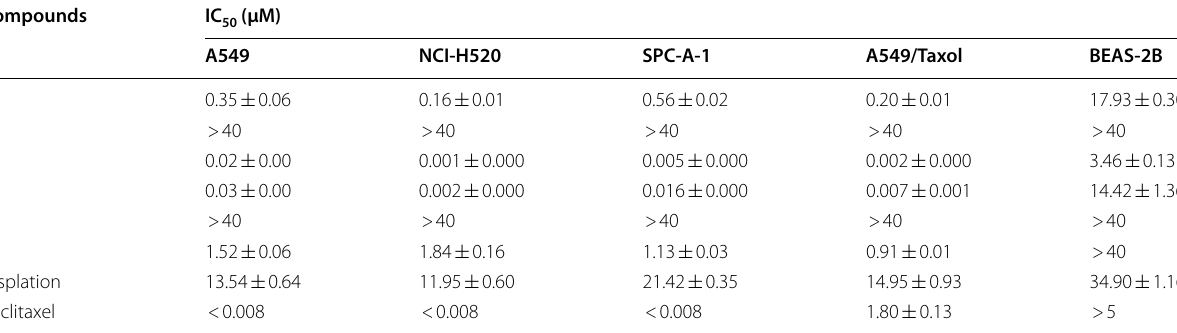
Table 5 Cytotoxicity of compounds isolated from the active fractions (Frs. B‑1–6 and B‑1–7) against the A549, NCI‑H520, SPC‑A‑1, A549/Taxol, and BEAS‑2B cell